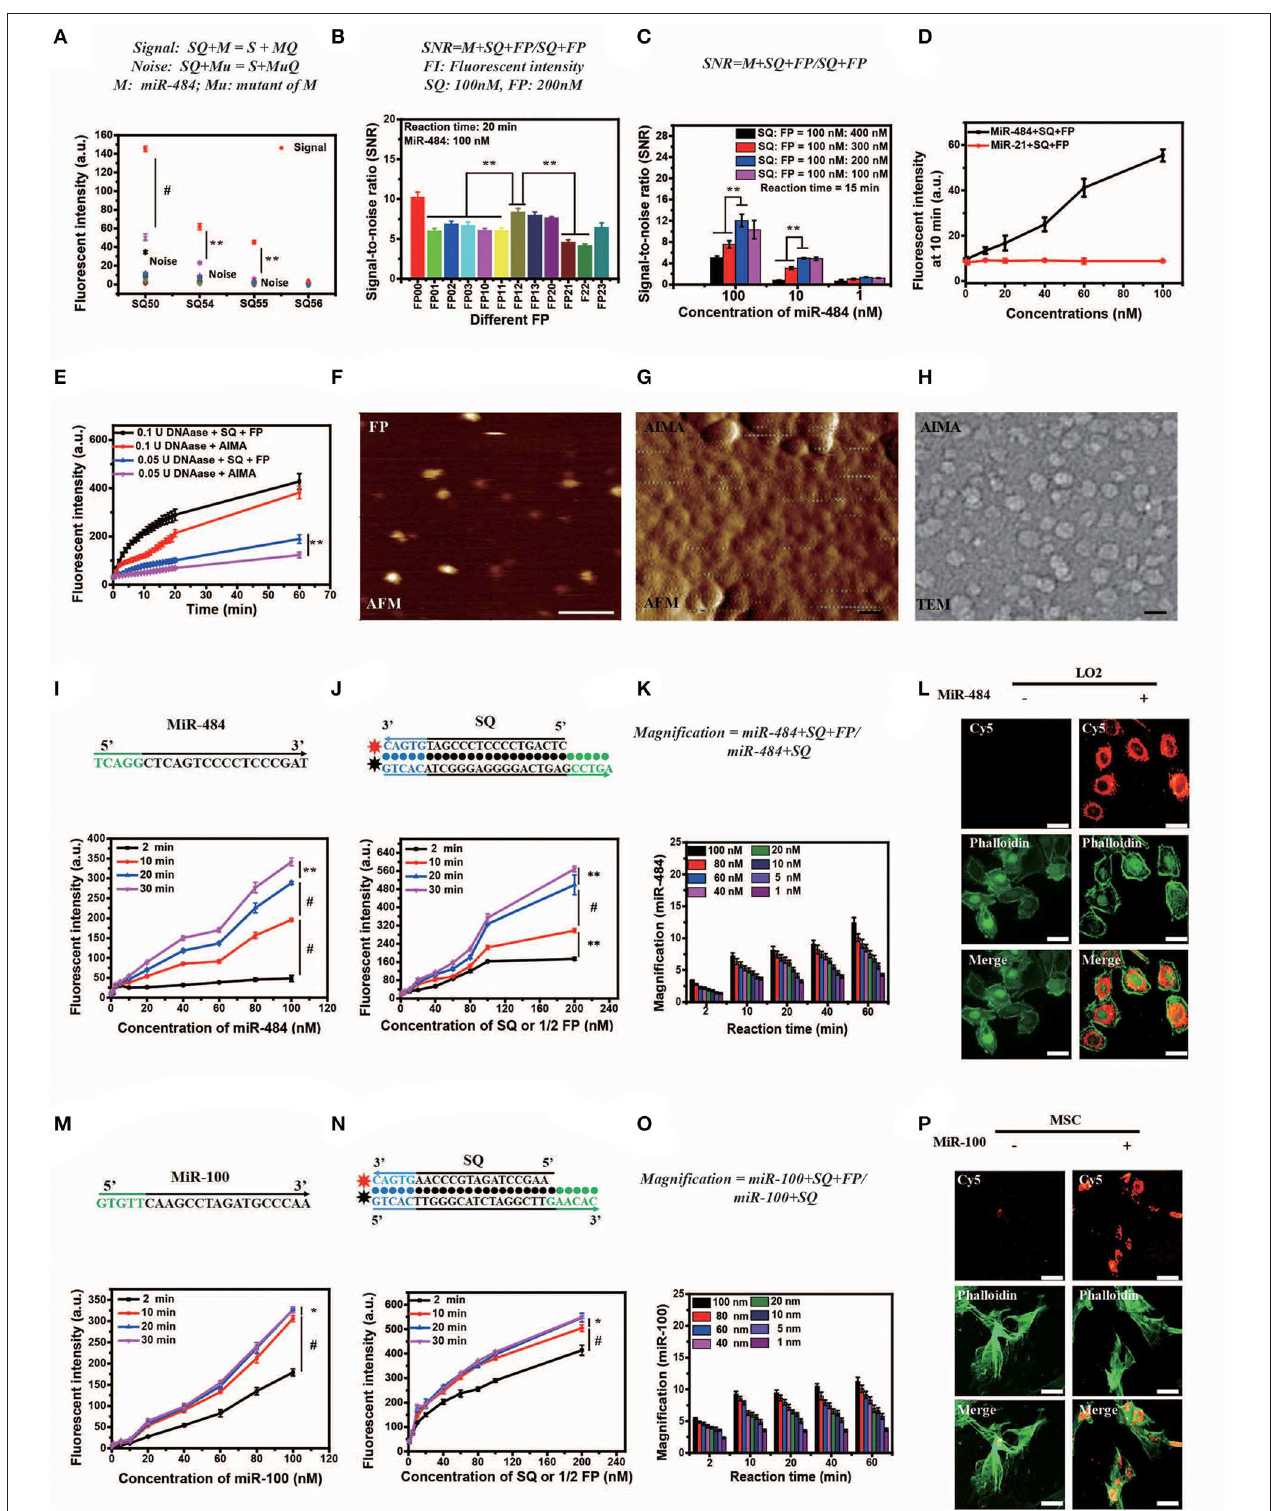
FIGURE 2 | Optimization, characterization, and in vitro and intracellular dynamics of artificial intelligent signal amplification (AISA) systems with target RNA. (A) Fluorescence intensity generated by different SQs and miR-484 or its 11 mutants measured using a fluorospectrophotometer [signal indicates the fluorescence intensity generated by miR-484, noise indicates the fluorescence intensity generated by its 11 mutants (shown in Table S1 )]. (B) Signal/noise ratio (SNR) generated by